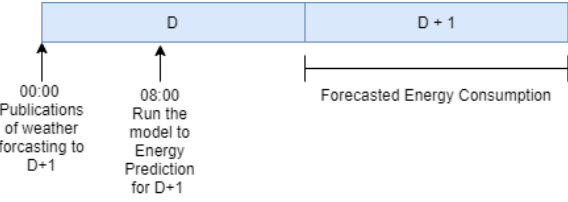
Figure 5. Real setting of the energy demand forecasting problem. D: day.